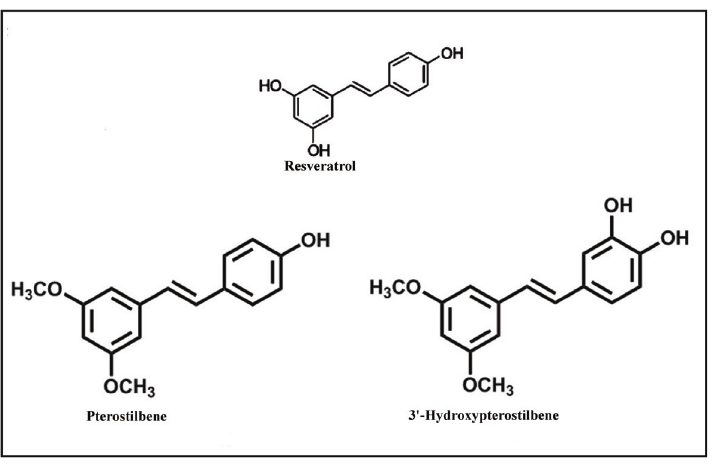
Fig 1. Stilbenoid analogues of